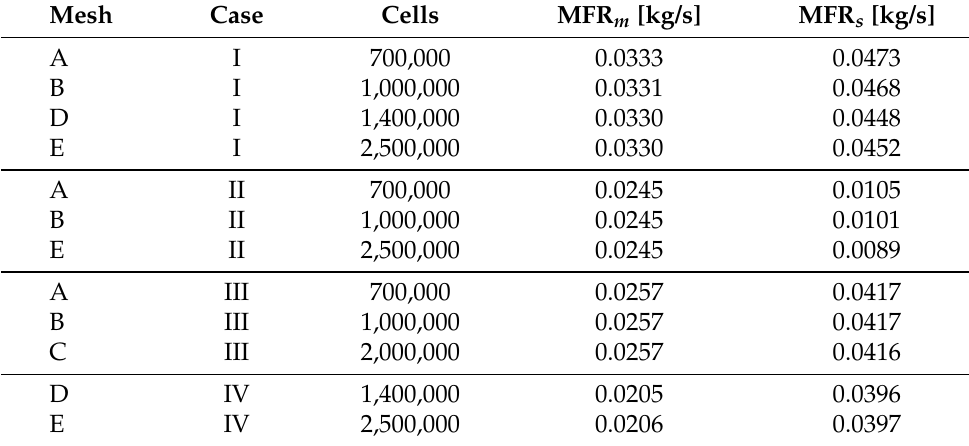
Table 4. Mesh convergence study with different mesh